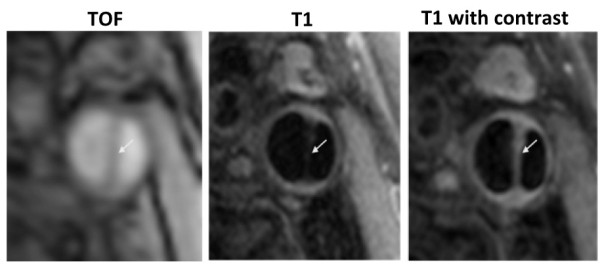
Post-operative dissection of the carotid artery. The patient had undergone endarterectomy several years before but remained symptom free, however a clear intimal flap is seen in all three images (arrow). The time-of-flight image on the left confirms the presence of a false lumen with blood flow. The T1W image (centre) shows the presence of an intimal flap, which shows an increase in signal intensity after the administration of gadolinium contrast (right), suggestive of a high degree of vascularity.